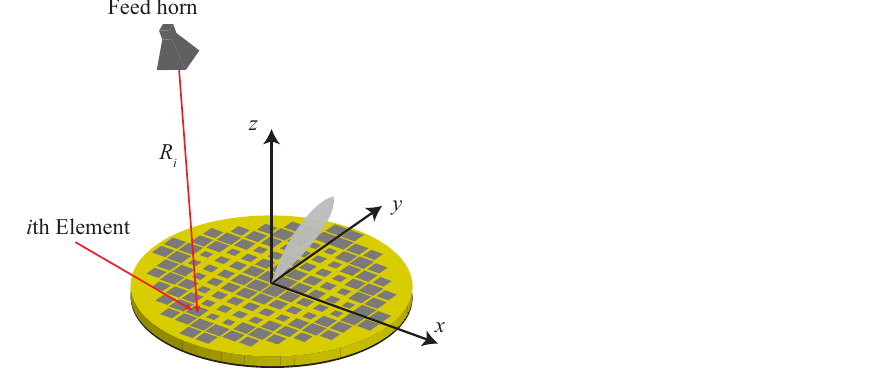
Figure 1. The geometry of a reflectarray antenna consisting of a feed antenna and a single planar aperture consisting of numerous spatial phase